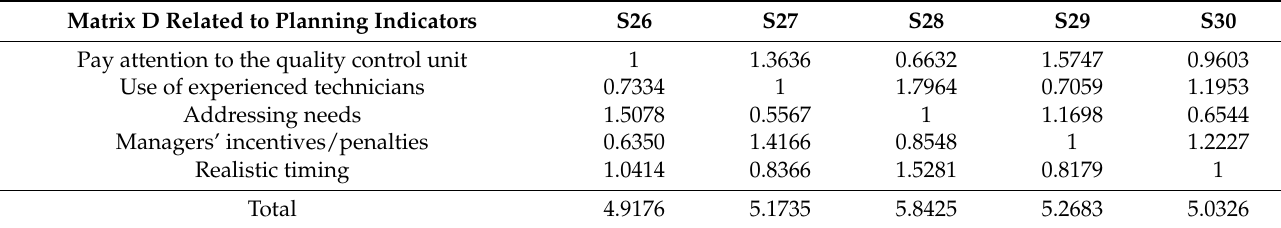
Table 23. Pairwise comparison matrix related to planning indicators.